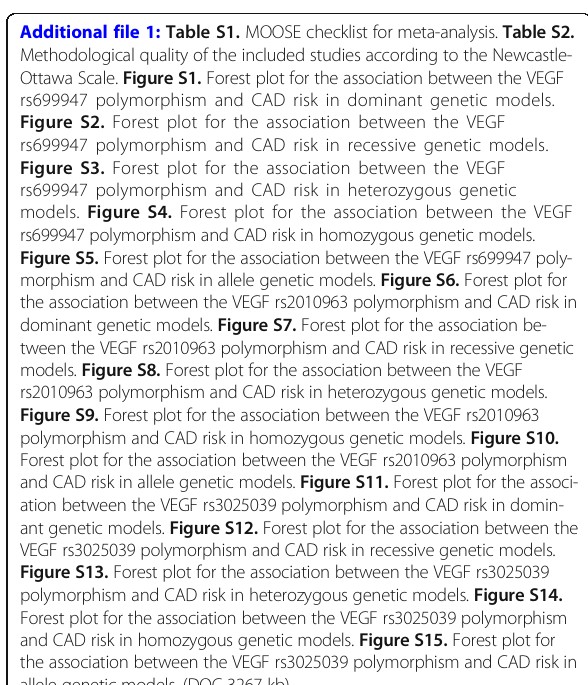
Additional file